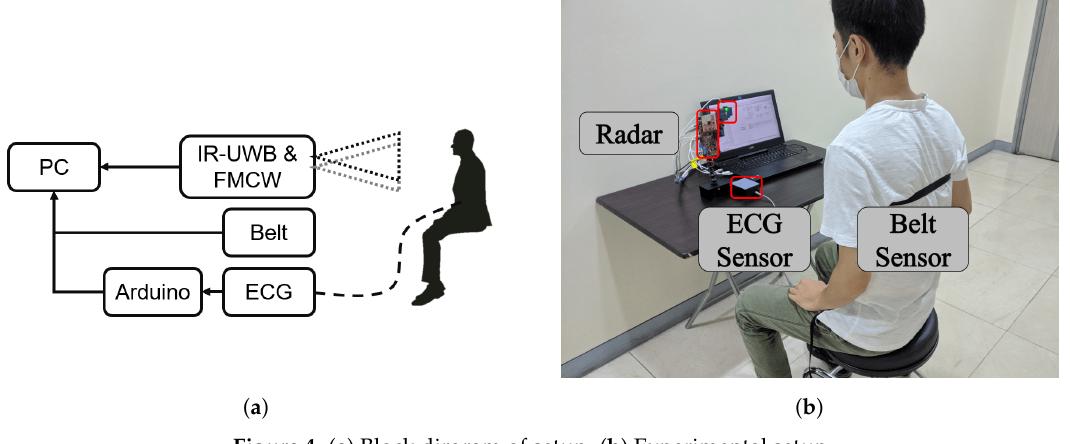
Figure 4. ( a ) Block dirgram of setup. ( b ) Experimental setup.